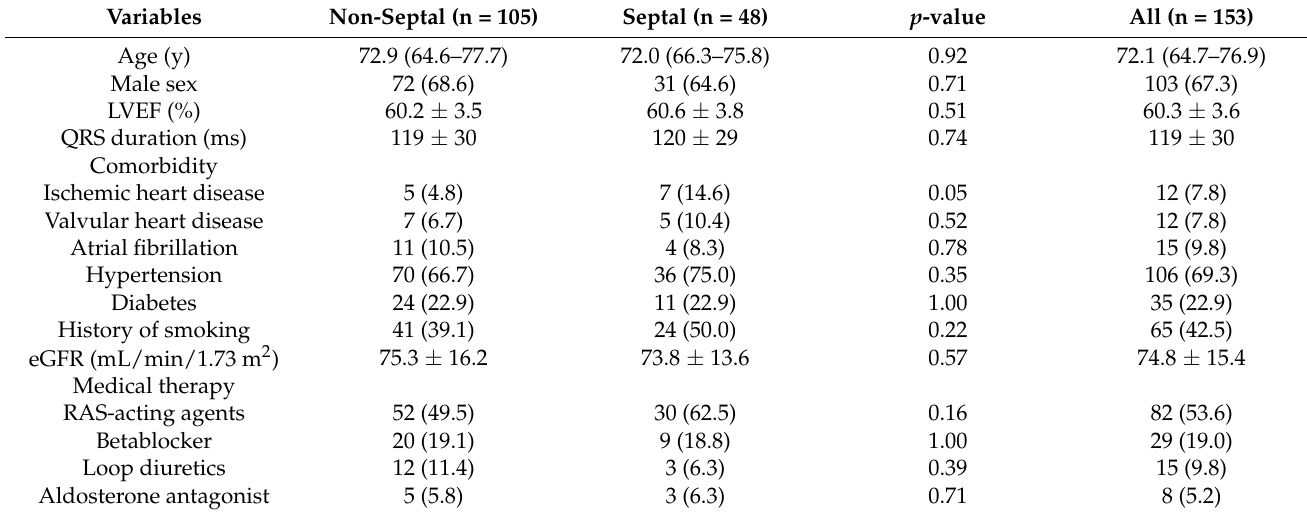
Table 1. Baseline characteristics in patients with RV non-septal and RV septal lead position.